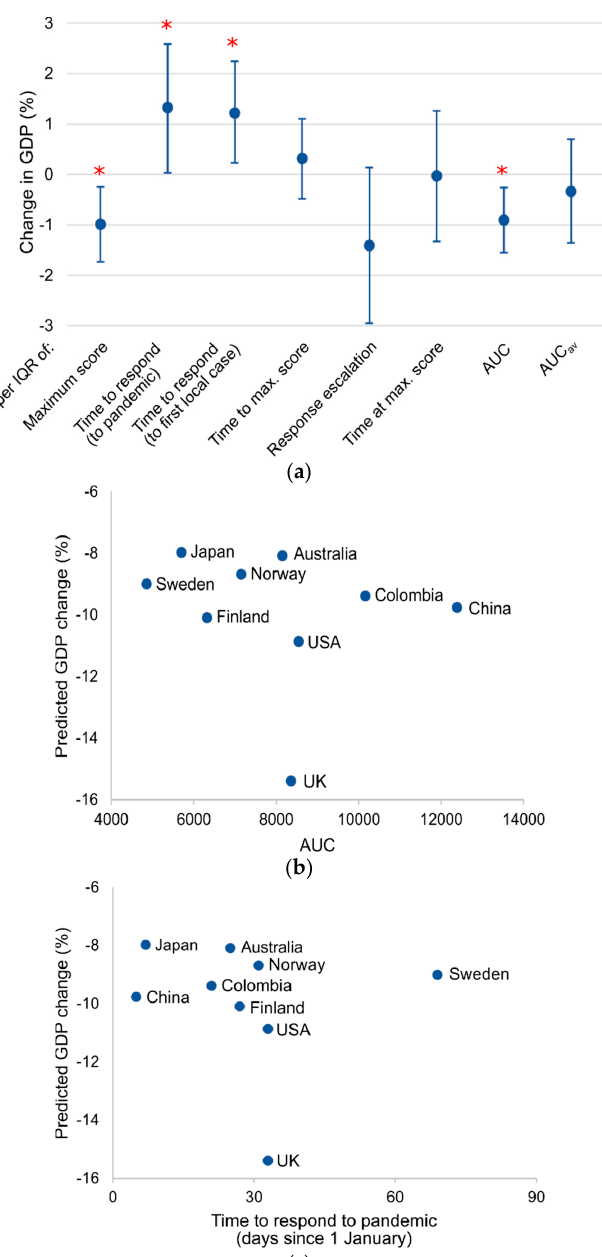
Figure 2. The effect of COVID-19 responses on annual GDP growth rates. Annual GDP growth rates were estimated by the OECD.13 ( a ) Results of multilevel mixed-effect linear regression models of change in annual growth rate 2019–2020 per interquartile range (IQR) due to a double-hit scenario (38 countries; multivariate analyses adjusted for GDP). Error bars show 95% confidence intervals; * p < 0.05. The difference between the 2019 and 2020 growth rates is shown against ( b ) response stringency and duration (area under the curve; AUC) and ( c ) the time for each country to respond to the pandemic (stringency index > 0); this includes both preventative restrictions that may have preceded confirmed cases in those countries.